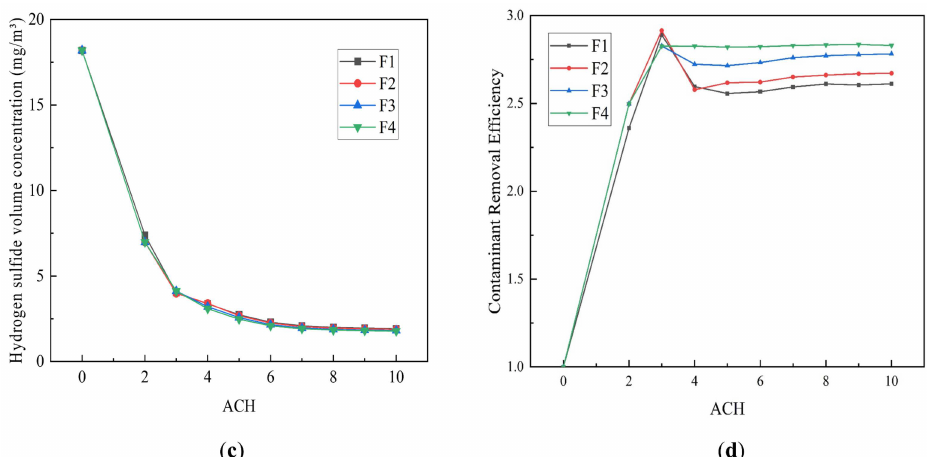
Figure 11. Changes in VAC and CRE as functions of the ACH (unit: h − 1 ) for ammonia and hydrogen sulfide. Ammonia: ( a ): VAC; ( b ): CRE; Hydrogen sulfide: ( c ): VAC; ( d ): CRE.